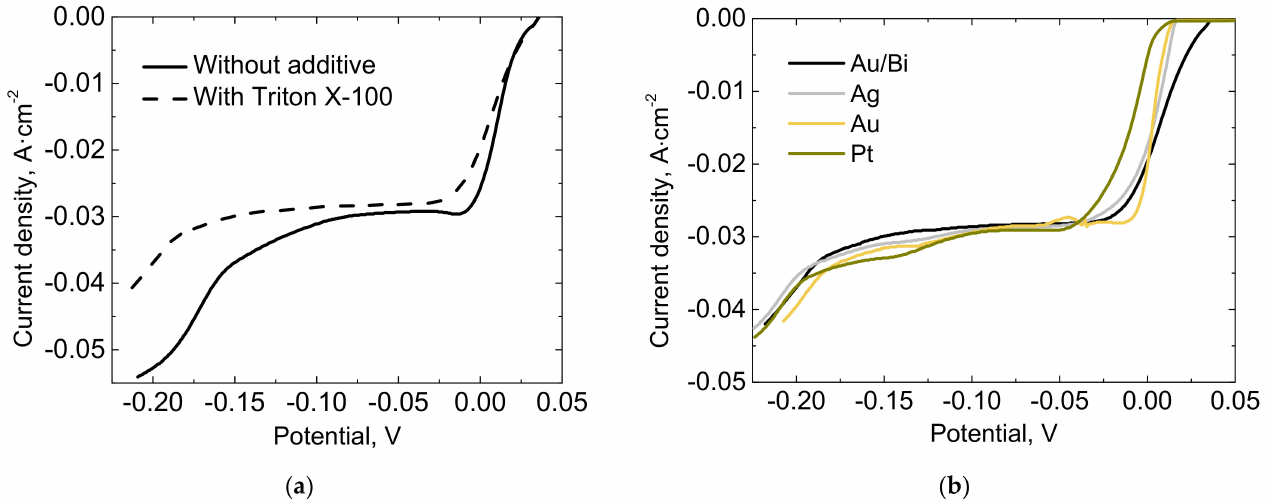
Figure 1. ( a ) Cathodic polarization curves of Bi electrodeposition on Bi-coated (100 nm) Au electrode from solutions with and without the additive Triton X-100. ( b ) Cathodic polarization curves of Bi electrodeposition on Bi, Au, Pt and Ag substrates from solutions with the Triton X-100 additive.